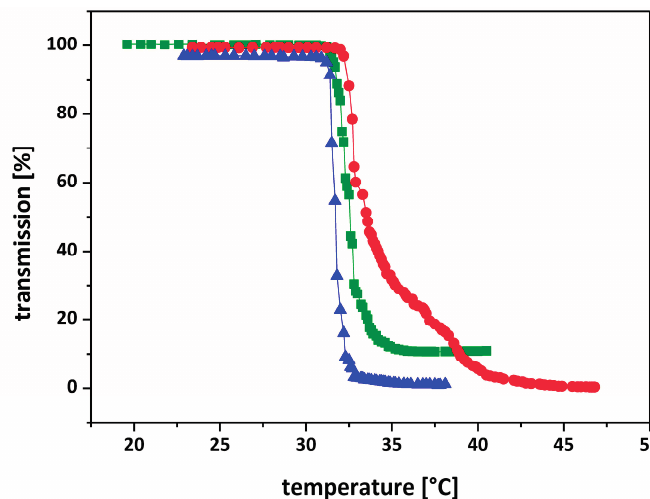
Figure 5. Transmittance curves of the star-like PNIPAAm homo polymers 7b (from 7-Cl- β -CD ( ▲ )), 8a (from 14 Cl- β -CD ( ● )) and 9b (from 21 Cl- β -CD ( ■ )) in aqueous solution (0.1